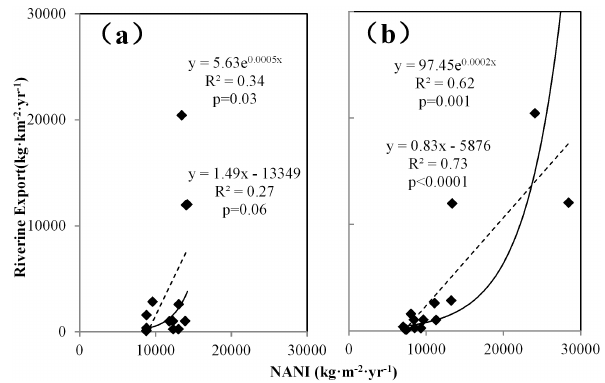
Figure 5. Comparison of relationships between NANI and riverine N export. Results from the area-weighting method (a) and the land use-weighting method (b) . Dashed line represents linear fitting re- sults and solid line is for an exponential fitting. Relationships from both fitting functions were significant ( p < 0 . 01) for the land use- weighting method, but neither linear nor exponential relationships were found to be statistically significant in results from the area- weighting method.